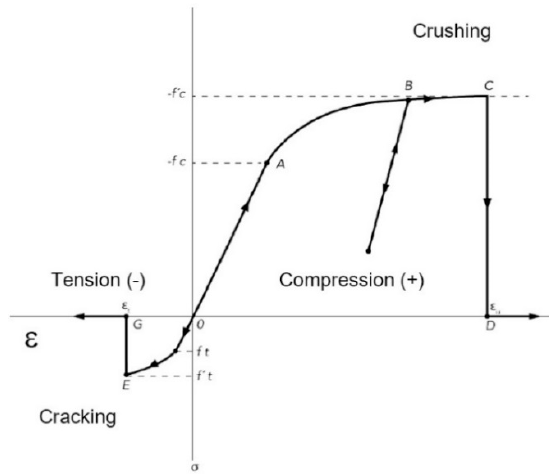
Figure 2. Uniaxial stress-strain curve for plain concrete. Source: [14].